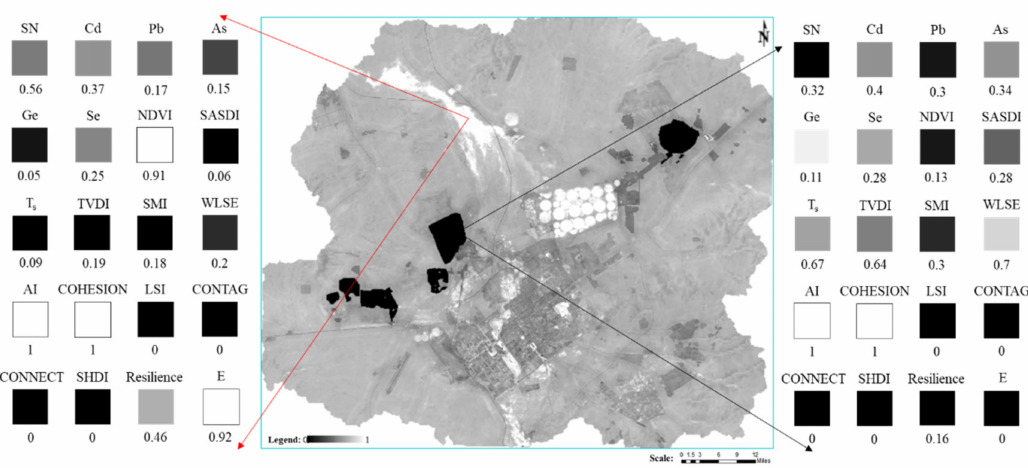
Figure 12. Analysis of landscape ecological health problems at any two